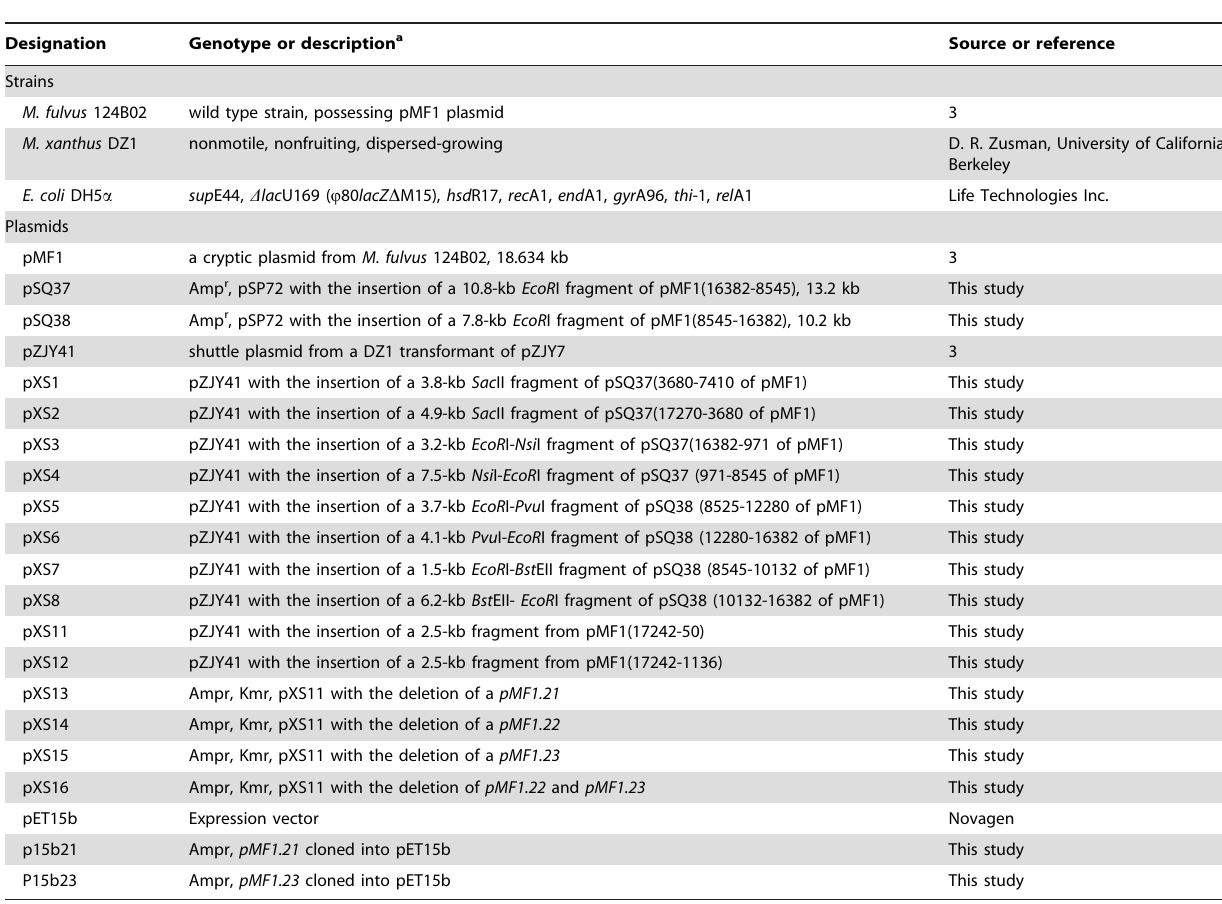
Table 1. Bacterial strains and plasmids used in this